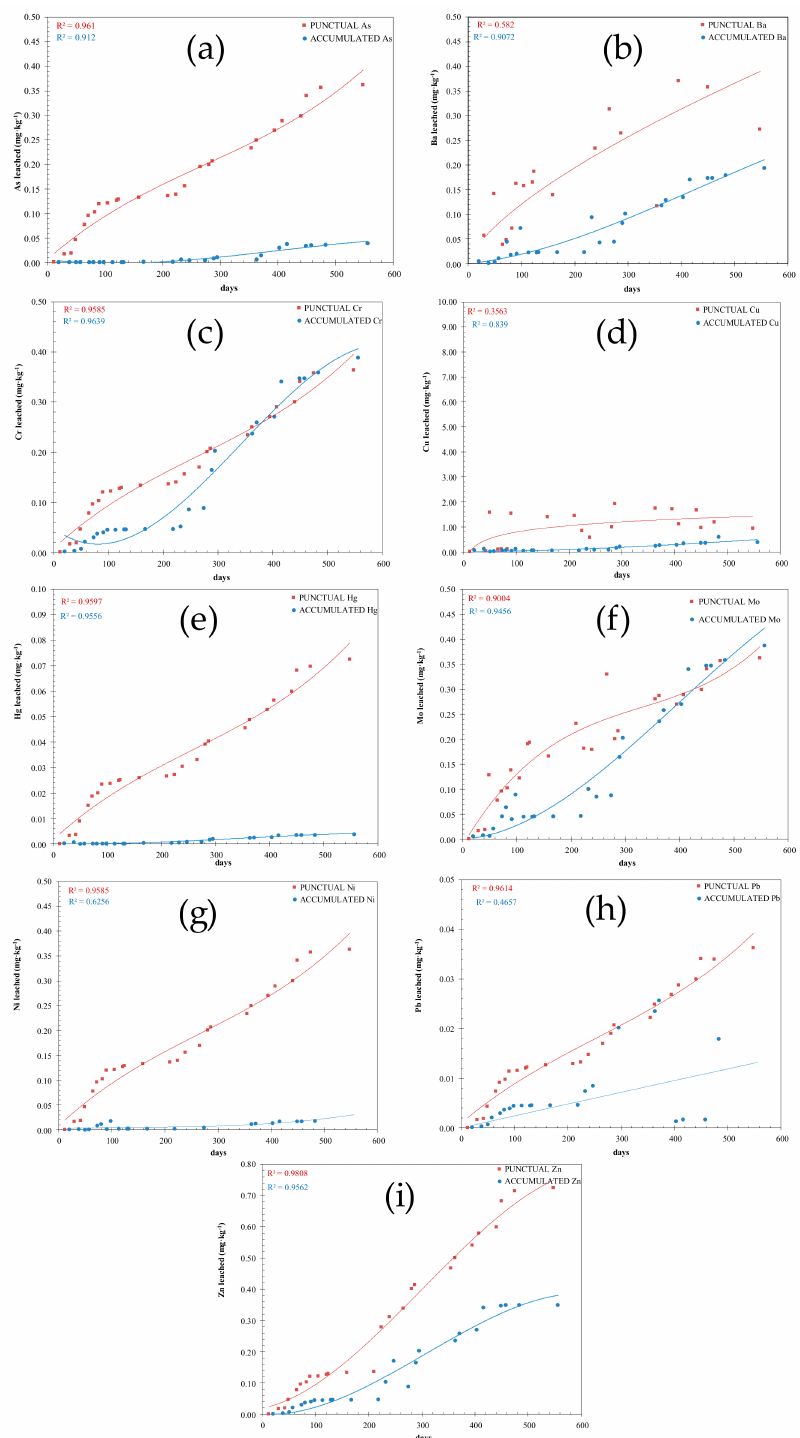
Figure 8. Concentration for both “accumulated” and “punctual” samples ( a ) As, ( b ) Ba, ( c ) Total Cr, ( d ) Cu, ( e ) Hg, ( f ) Mo, ( g ) Ni, ( h ) Pb and ( i )